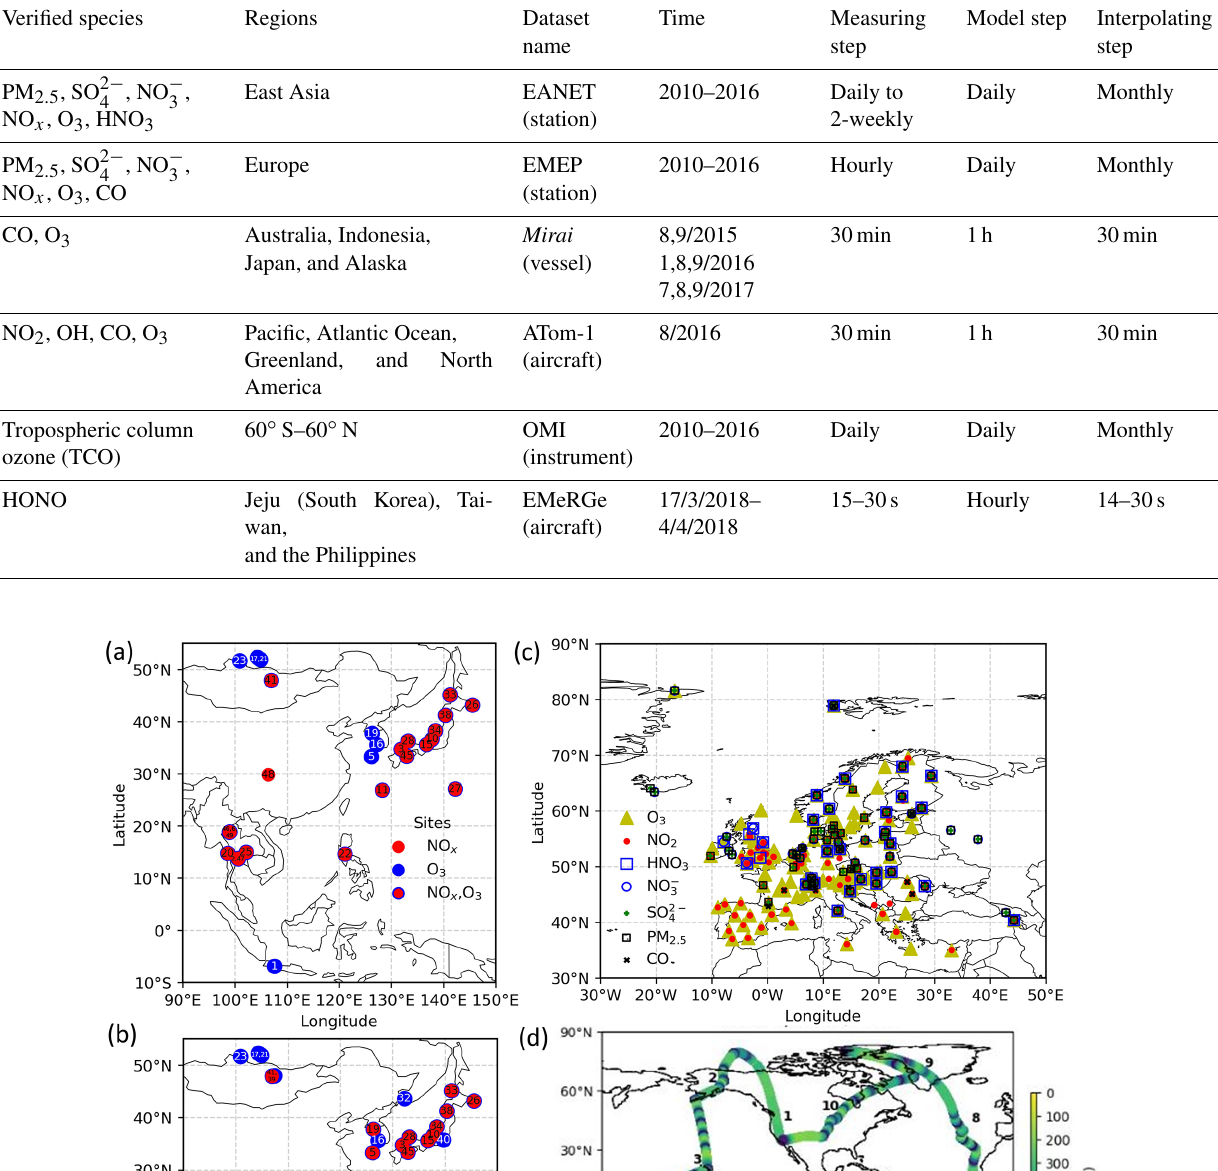
Table 4. Lists of the datasets used in this study for verification. Related simulations with their original model time step are interpolated to the comparing time step.